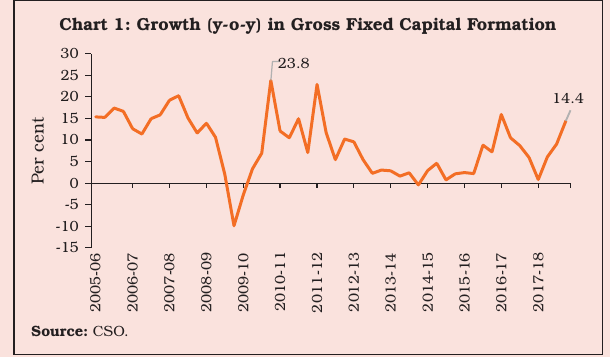
Chart 1: Growth (y-o-y) in Gross Fixed Capital